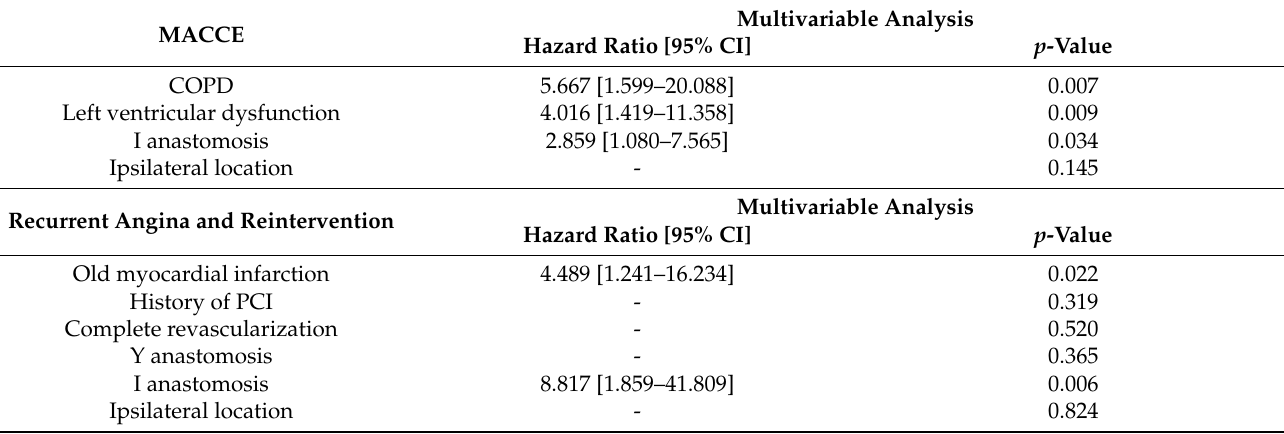
Table 5. Risk factor analysis (inverse probability weighting-adjusted